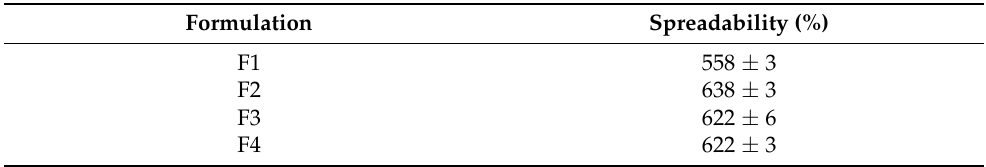
Table 4. The spreadability values of hand sanitizer gel formulations. The result represents the mean ± SD of three replicates ( n = 3).